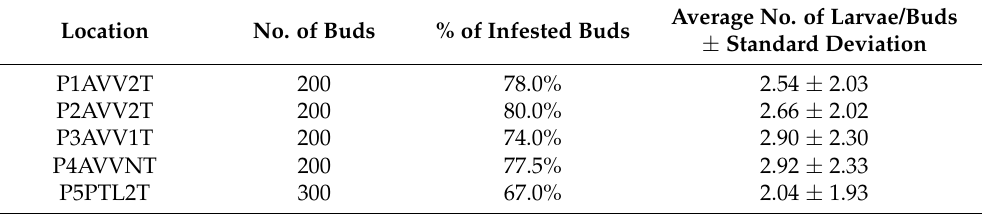
Figure 2. Larvae L1 ( a ) and ( b ) of D. kuriphilus inside chestnut buds, 2018 (binocular magnifying glass images).